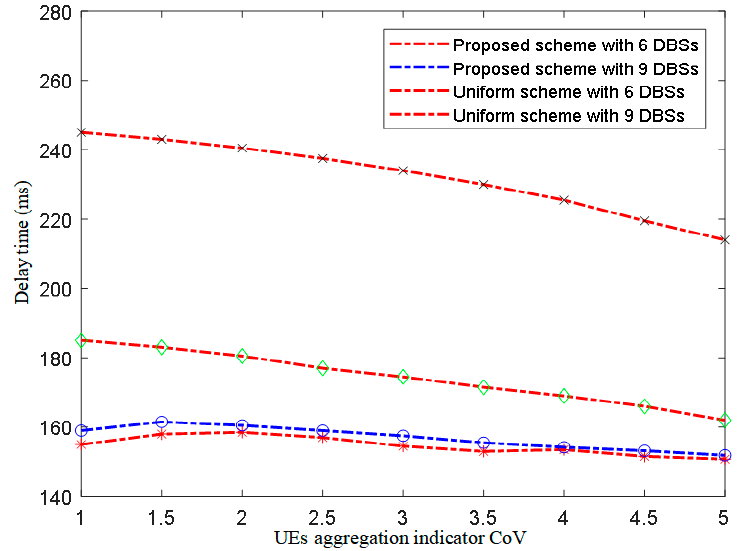
Figure 8. Delay time vs. CoV.